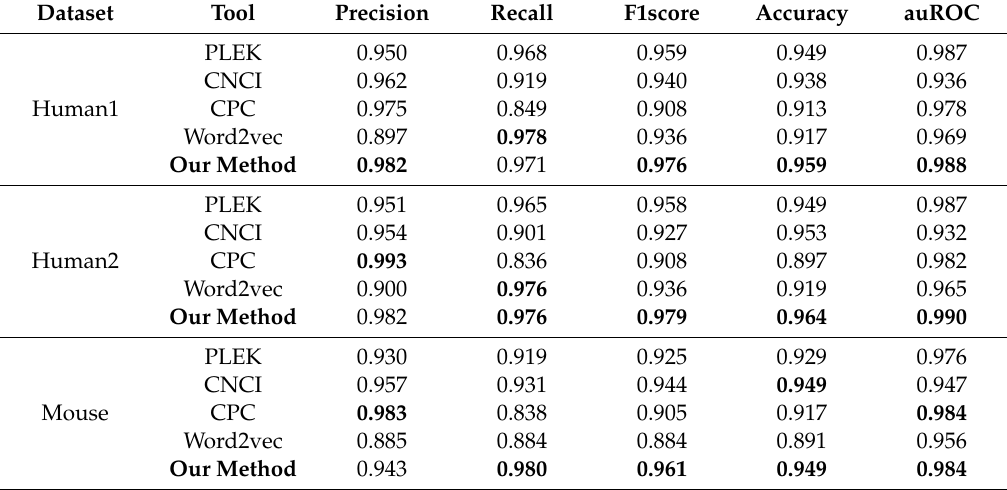
Figure 3. The ROC curve of human and mouse, with “false positive rate” as the horizontal axis and “true positive rate” as the vertical axis. Different method results are marked in different colors. Particularly, our method is marked in green. Table 3. Classification performance for four different methods in lncRNA prediction experiments.